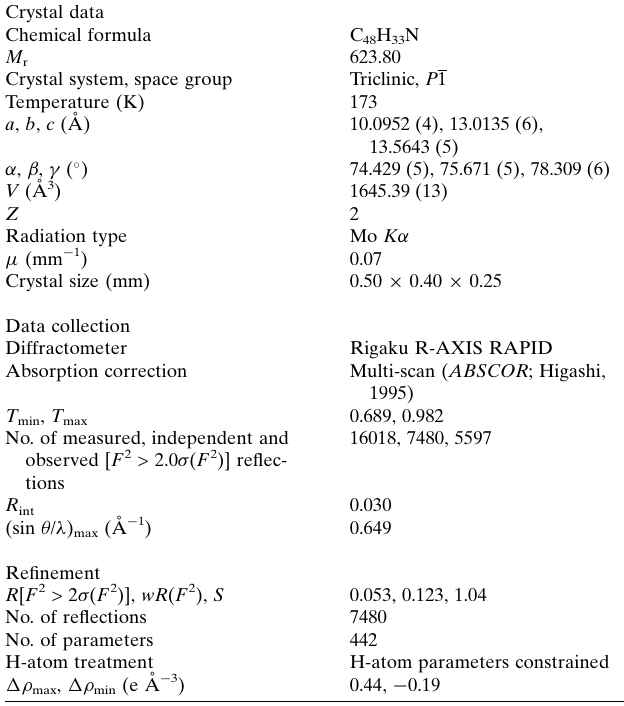
Table 1 Hydrogen-bond geometry (A˚ , (cid:4) ). Cg 1, Cg 2 and Cg 3 are the centroids of the rings C24–C28/C33, C2–C7 and C12–C17, respectively.